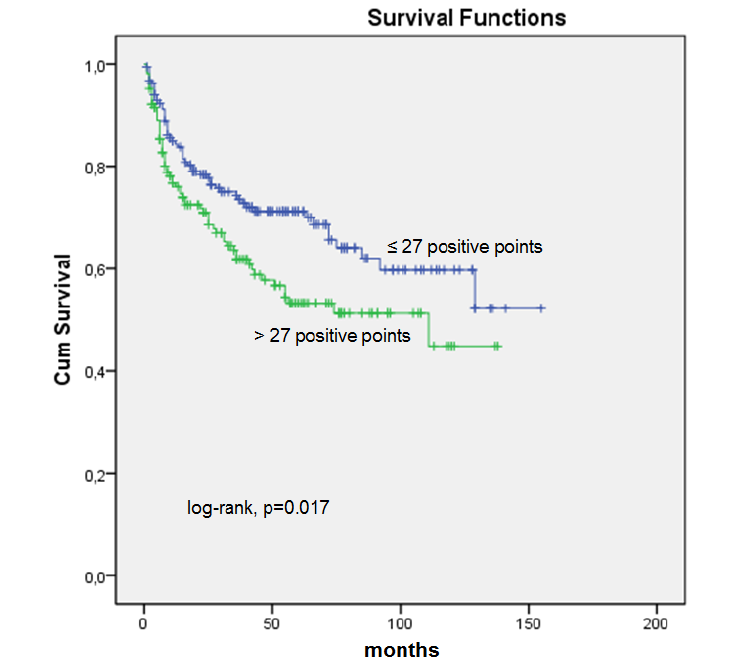
Figure 2 - Kaplan-Meier product-limit analysis shows time to PSA biochemical progression-free outcome by the median value of tumor extent evaluated as positive points in surgical specimens. Cum ,